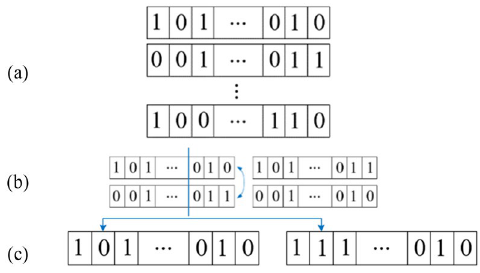
Figure 4. ( a ) Binary chromosome, ( b ) crossover, ( c )